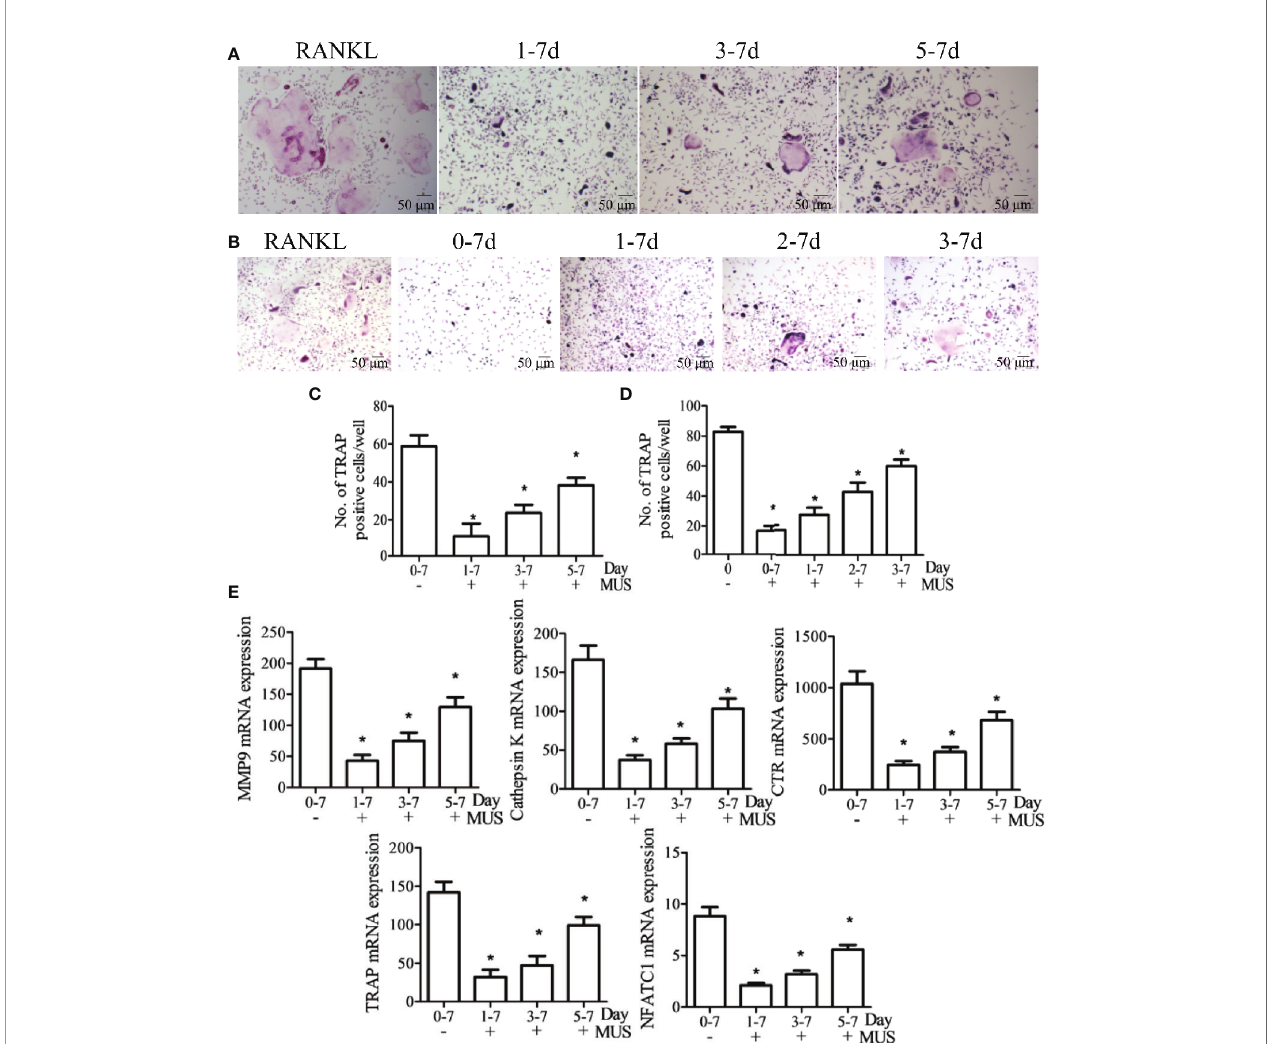
FIGURE 4 | Muscone inhibits osteoclastogenesis only at an early stage. After induction of M-CSF (20 ng/ml) and RANKL (50 ng/ml) on day 0, BMMs and RAW264.7 cells are divided into groups according to the different times that 40 m M muscone is added. (A, C) Besides the RANKL group, BMMs are divided into three groups: day 1-7 group, day 3-7 group, and day 5-7 group, since muscone is added on day 1, 3, and 5, respectively. (B, D) And similarly, RAW264.7 cells are divided into four groups: day 0-7 group, day 1-7 group, day 2-7 group, and day 3-7 group, as muscone is added on day 0, 1, and 3, respectively. On Day 7 after RANKL stimulation, TRAP staining is performed. (E) On day 7, mRNA expression in BMMs, including MMP-9, Cathepsin K, CTR, TRAF6, TRAP, and NFATc1, are detected by RT-PCT for each group. P < 0.05 vs. the control group, #P < 0.05 vs. the RANKL-induced